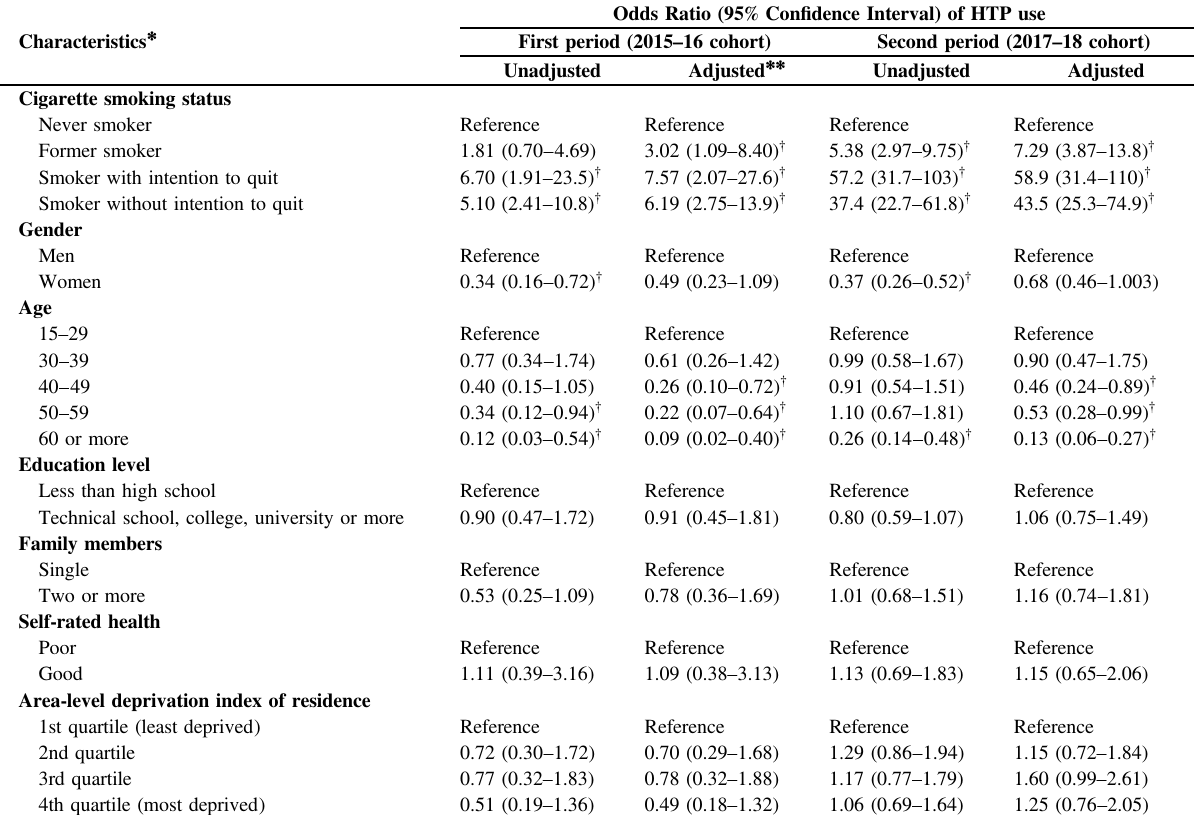
Table 3 Logistic regression models for current use of heated tobacco products (HTPs) Characteristics